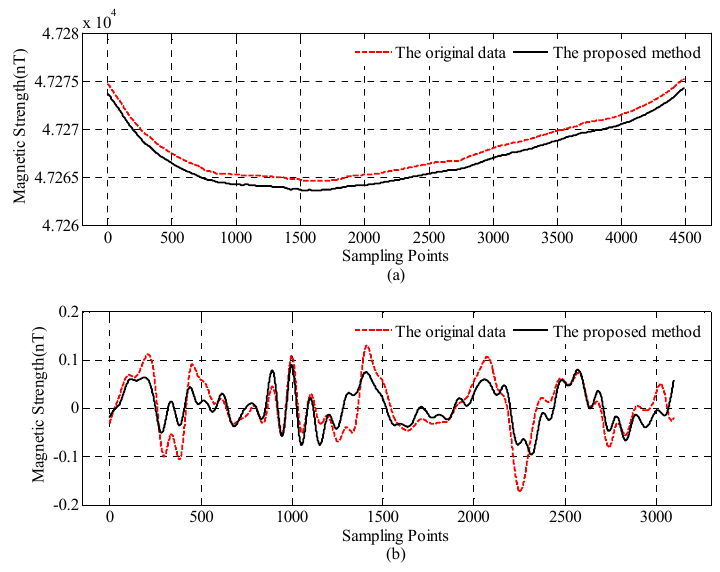
Figure 12. The magnetic field of the flight survey line-1: ( a ) total magnetic field and ( b ) interference magnetic field.